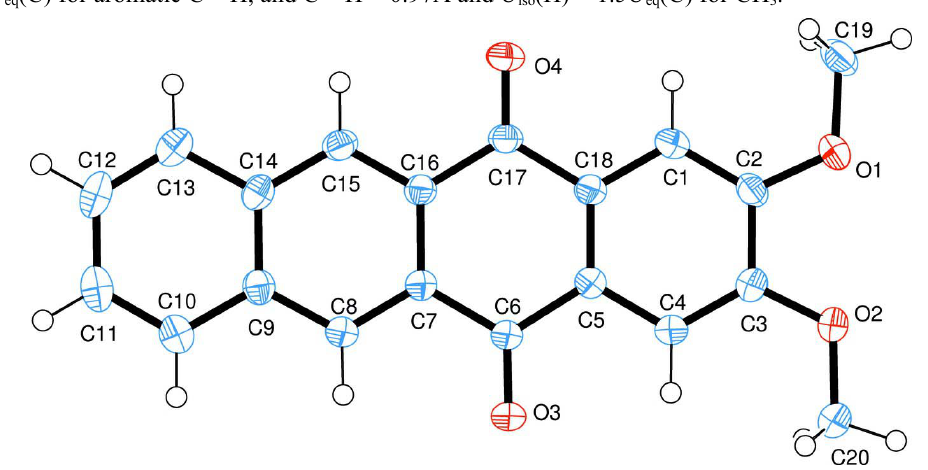
Figure 1 The molecular structure of the title compound showing 50% probability displacement ellipsoids for non-H